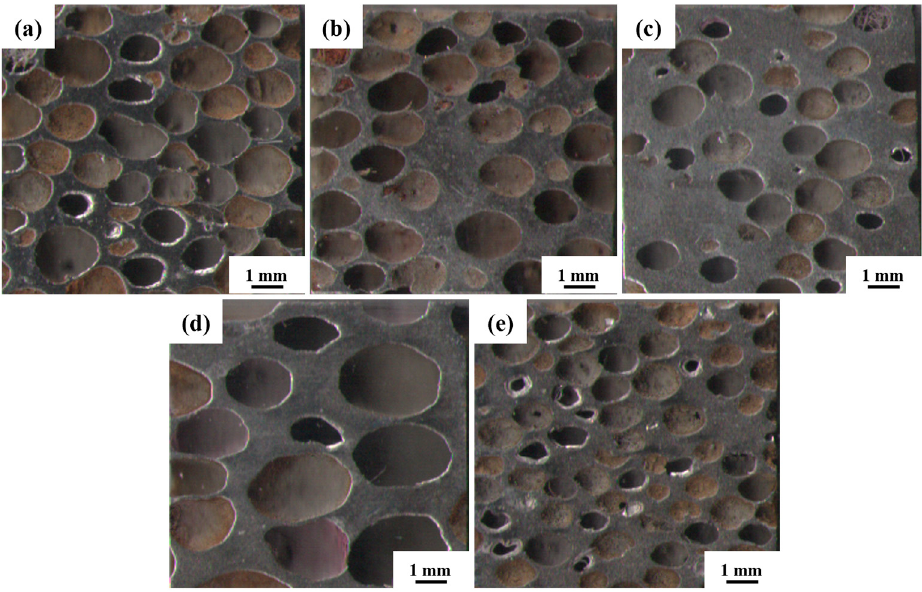
Figure 4. Macroscopic morphology of the longitudinal section of ( a ) 1#, ( b ) 2#, ( c ) 3#, ( d ) 4#, ( e ) 5# samples.